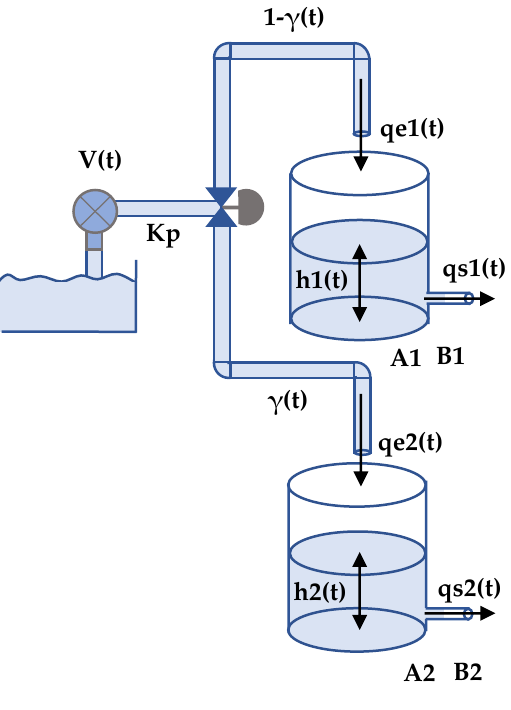
Figure 4. MIMO physical